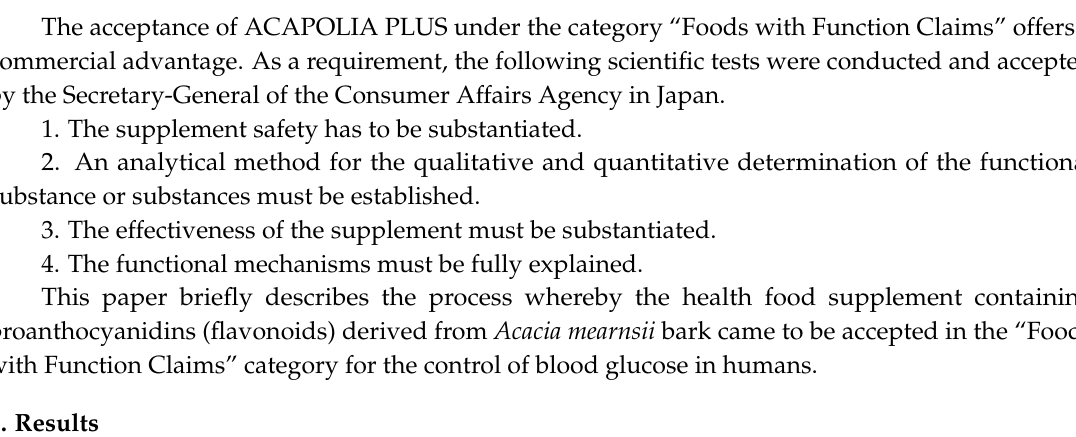
Figure 1. Categories of food products in Japan in April 2015.